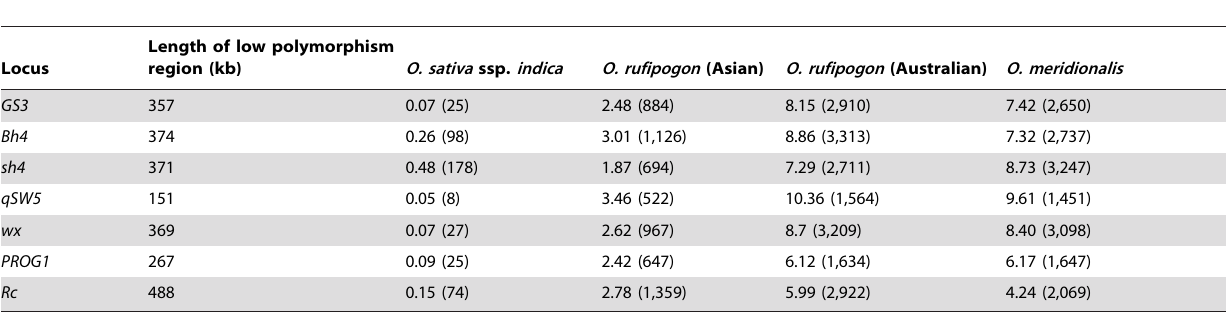
Table 2. Extent of loss in variation in the domestication and plant improvement genes as reflected by SNP distribution (SNPs per kb) in the 2 Mb genomic region surrounding